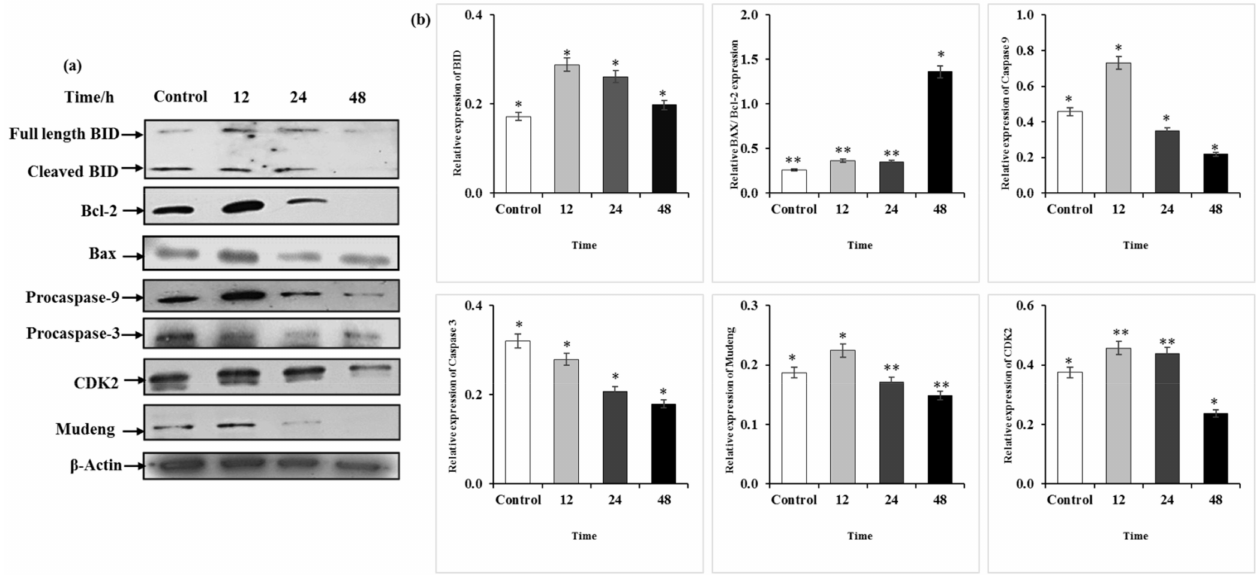
Figure 5. Protein expression of Hela cells treated with Q3G. ( a ): Representative western blots of BID, Bcl-2, Bax, Caspase-3, Caspase-9, Cdk2, Mudeng, and β -actin. ( b ): Quantitative analysis of the expression in comparison to β -actin, an internal control. * p < 0.05, ** p < 0.01 indicate the significant differences from the